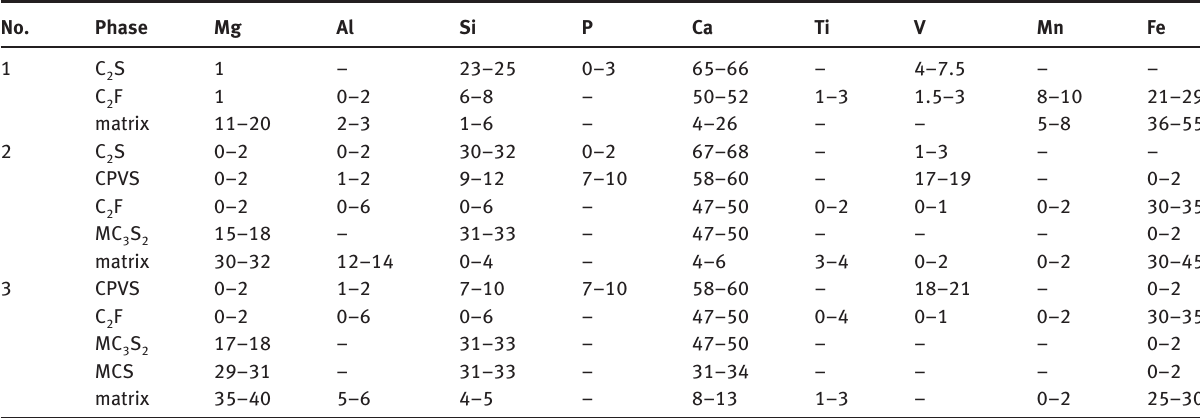
Table 3: Chemical composition of each phase in Fig. 1 (mole%)